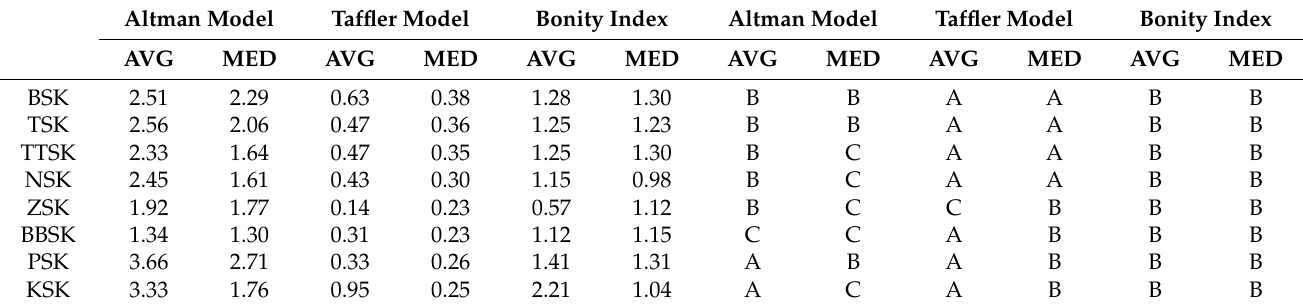
Table 3. Partial evaluation by Altman model, Taffler model, Bonity index at the level of individual regions—agricultural cooperatives. Altman Model